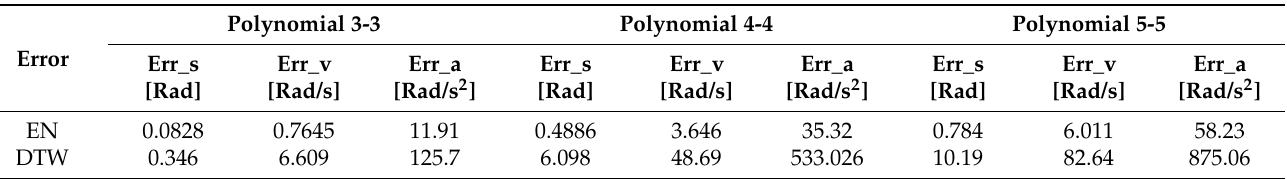
Table 6. Initial values of the Euclidean norm and DTW algorithm on displacement, velocity and acceleration, in the simulated cases with laws of motion of the polynomial class used as the original law of